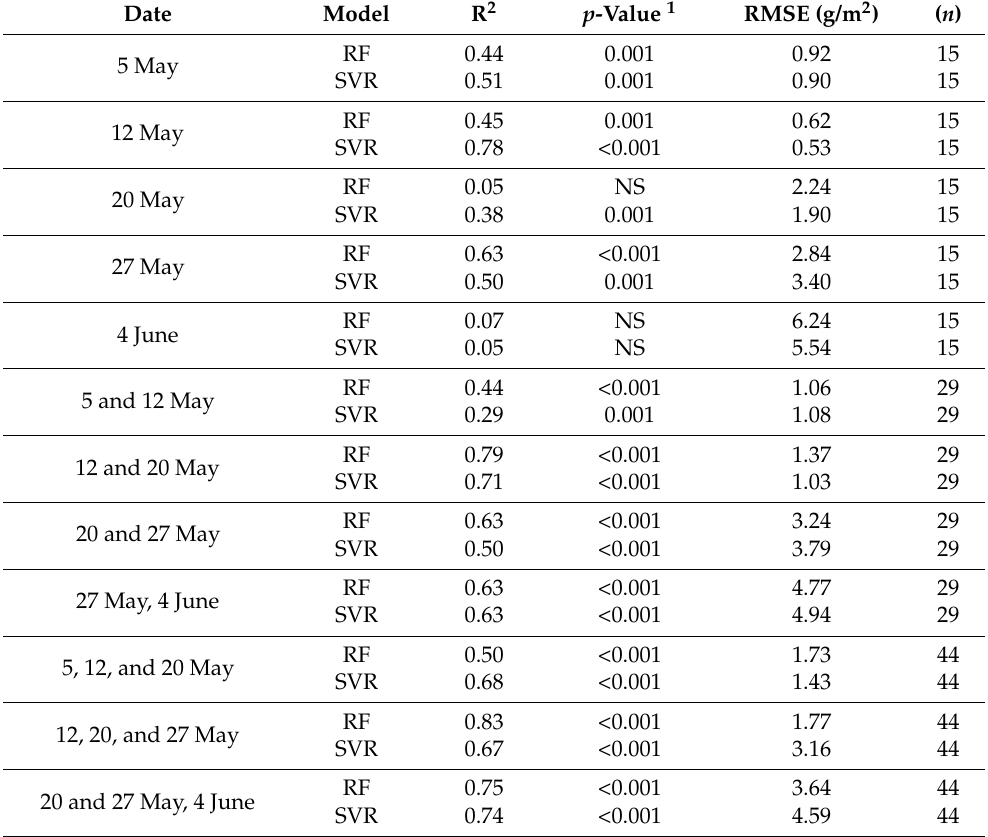
Table 8. Statistics for the validation of the PlanetScope canopy nitrogen models with 24 variables as a function of the date and the modelling approach (RF or